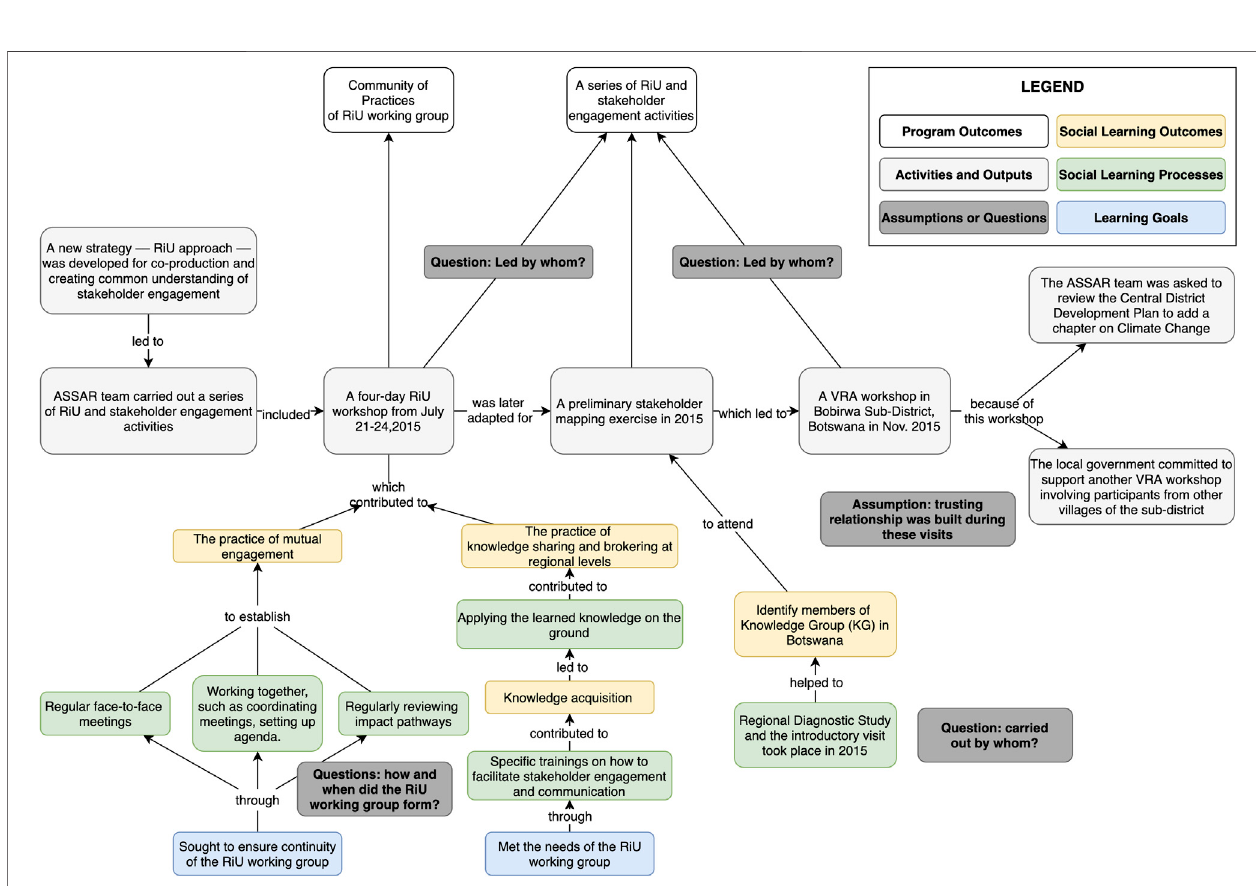
FIGURE 4 | The initial contribution pathway based on document analysis. Figure 4 illustrates an intermediate step of our method.